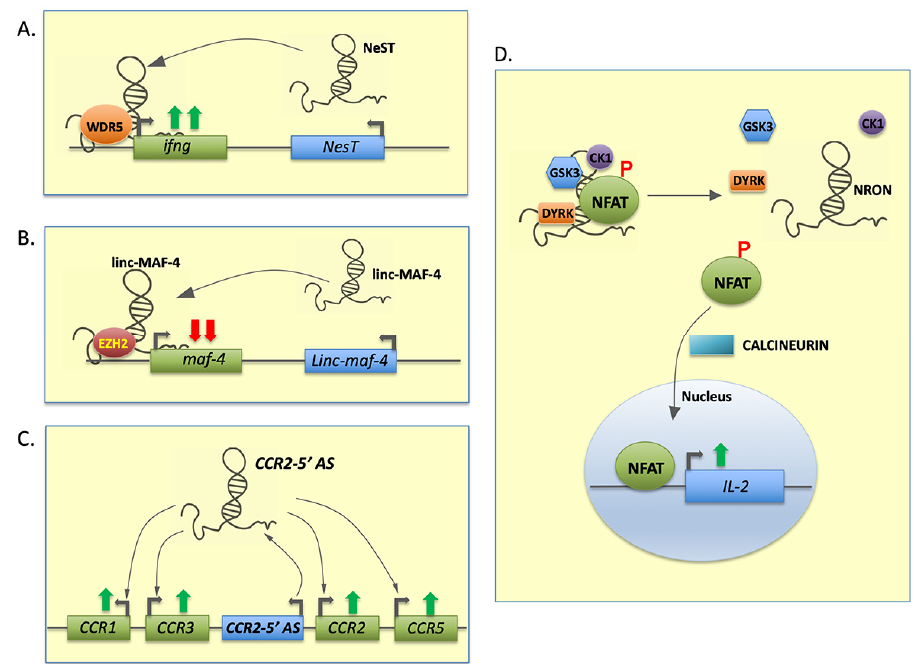
Figure 3. Long noncoding RNA regulates lymphoid cell di ff erentiation and function. Multiple lncRNAs are involved in lymphoid cell di ff erentiation and regulate polarization and e ff ector cell functions. ( A , B ) NeST and linc-MAF-4 interact with specific transcription factors and guide them to the IFNG and MAF-4 locus, respectively. This directly influences transcription of target genes and promotes the Th1 phenotype. ( C ) CCR2-5’ AS induces expression of various Th2 cytokines and facilitates GATA3 (critical Th2 transcription factor) function. ( D ) In resting CD8 cells, NRON sequesters a critical transcription factor NFAT. In activated T cells, calcineurin mediates dephosphorylation and nuclear translocation of NFAT. Green arrows denote transcriptional activation and red arrows denote transcriptional repression.